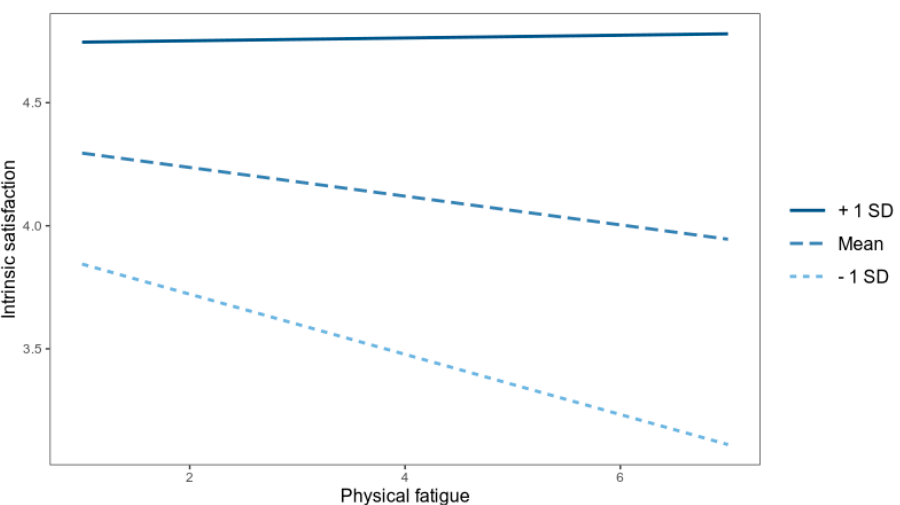
Figure 1. The relationship between physical fatigue and intrinsic job satisfaction by harmonious passion levels.